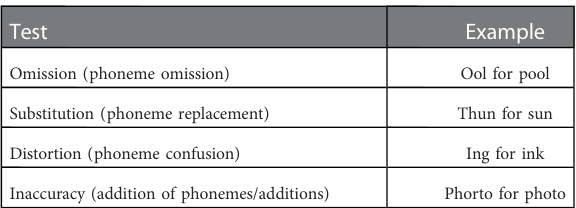
TABLE 1 Tests for articulation disorders based on the Adapted Orofacial Myofunctional Assessment Protocol (19,